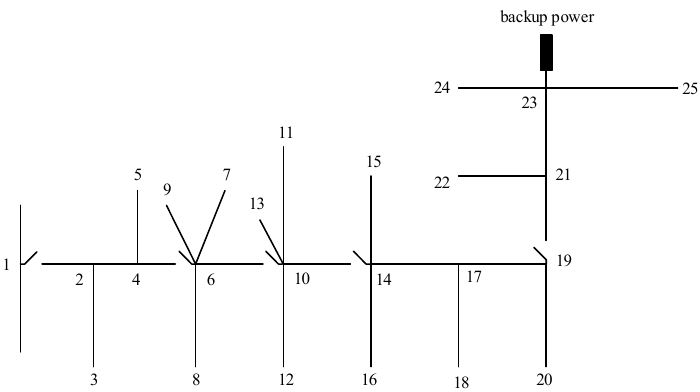
Figure 10. Example 1: optimal switch-distribution map (with contact, four switches).